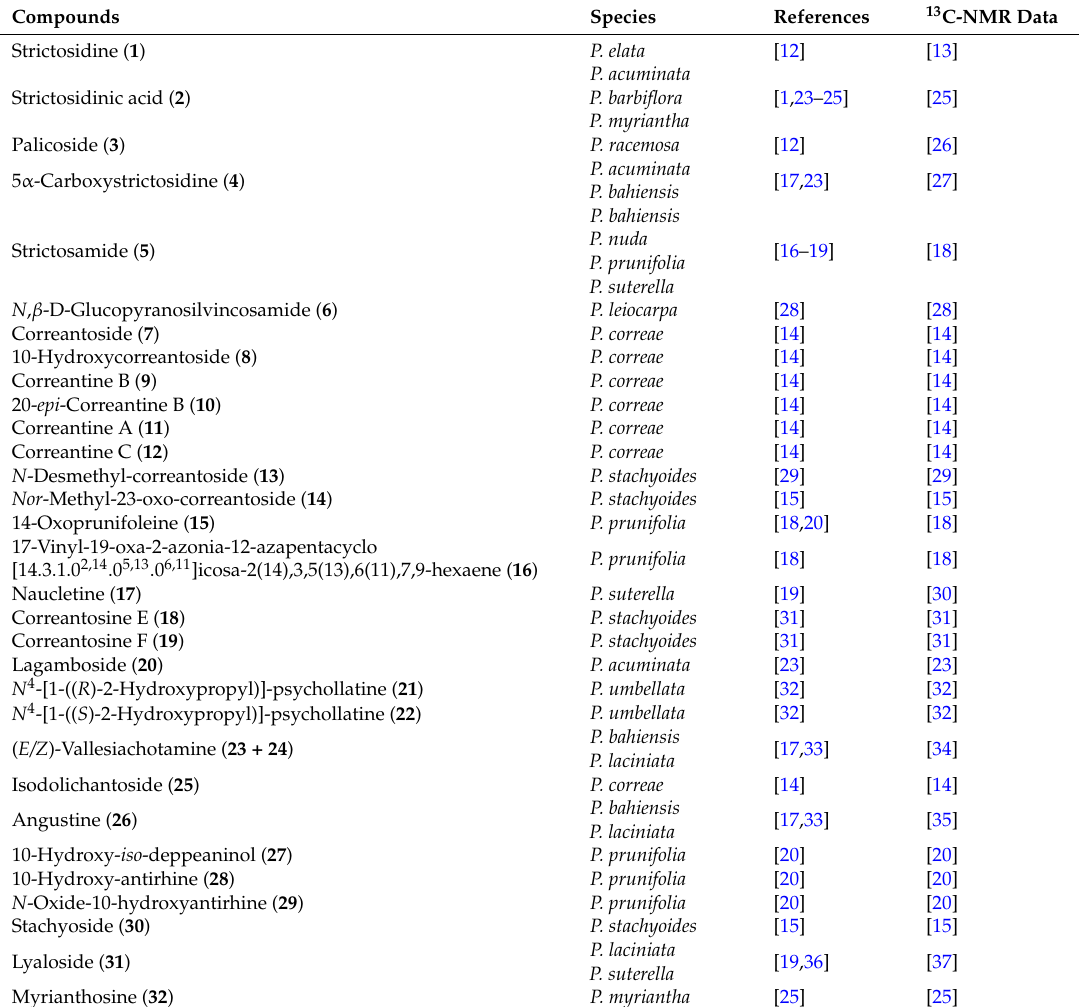
Table 1. Monoterpene indole alkaloids from Psychotria